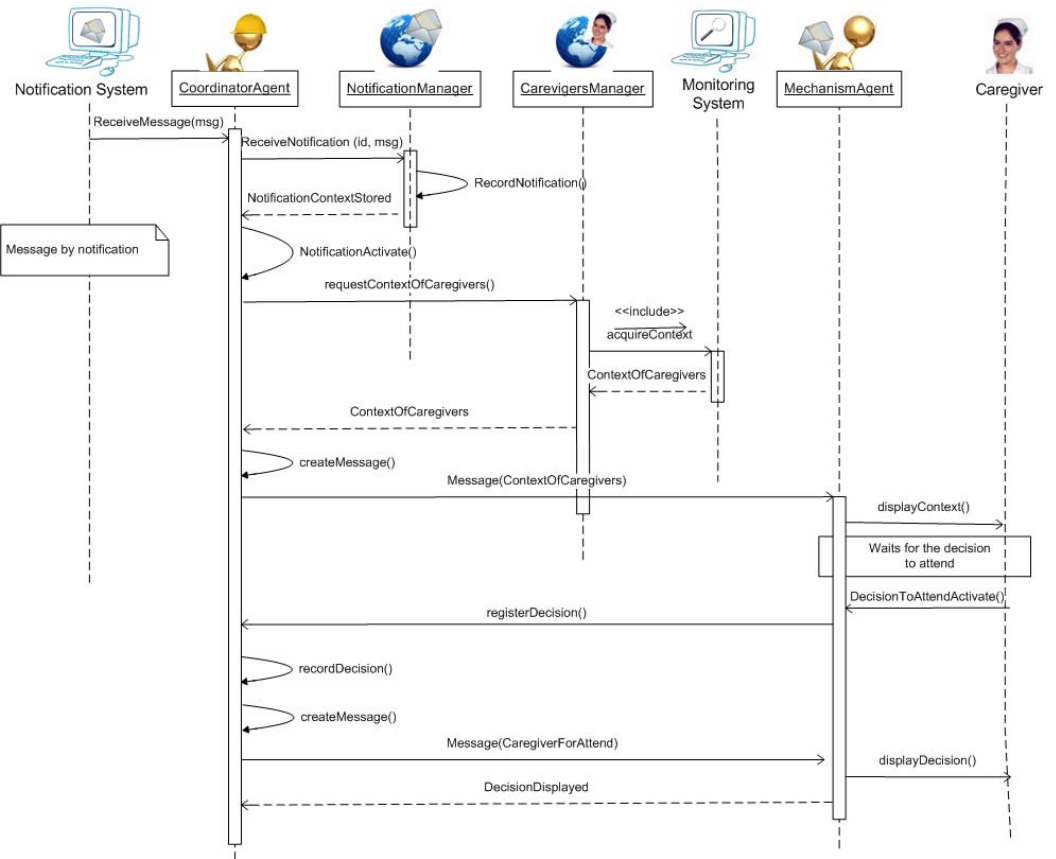
Figure 17. Sequence Diagram of the Communication-Coordination